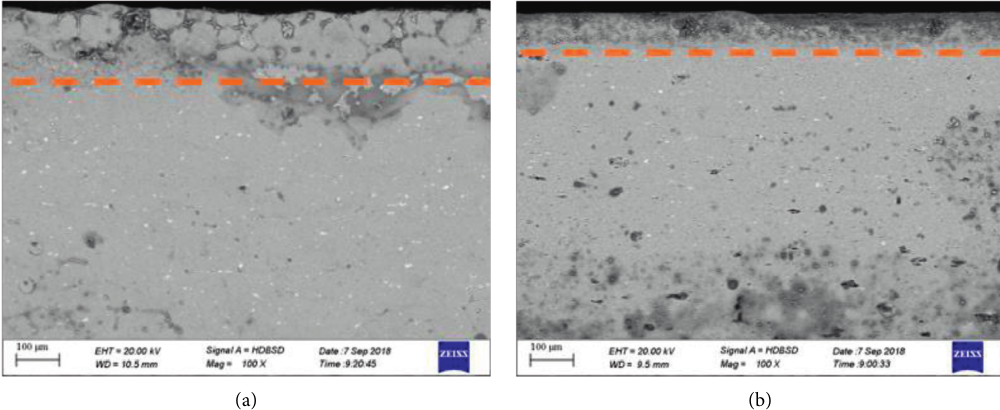
Figure 14: Microstructures of the 4343/3003/4343 clad sheets after brazing: (a) rolled to 40% and annealed at 410 ° C and (b) rolled to 10% and annealed at 410 ° C.